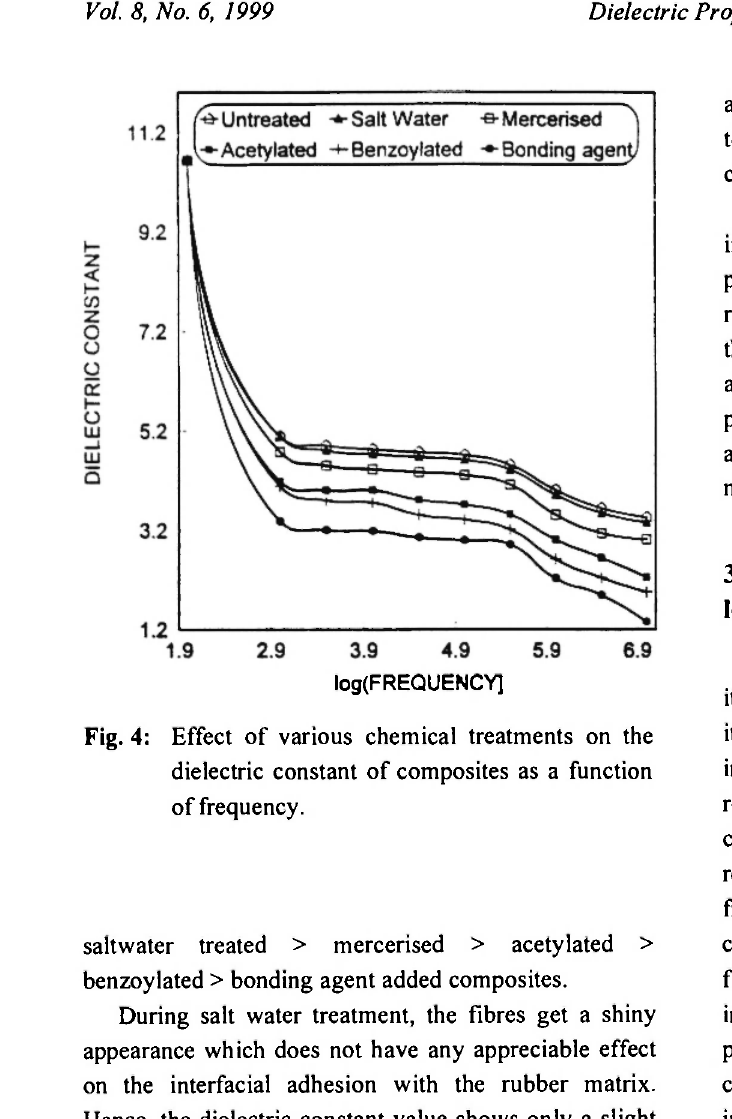
Fig. 4: Effect of various chemical treatments on the dielectric constant of composites as a function of